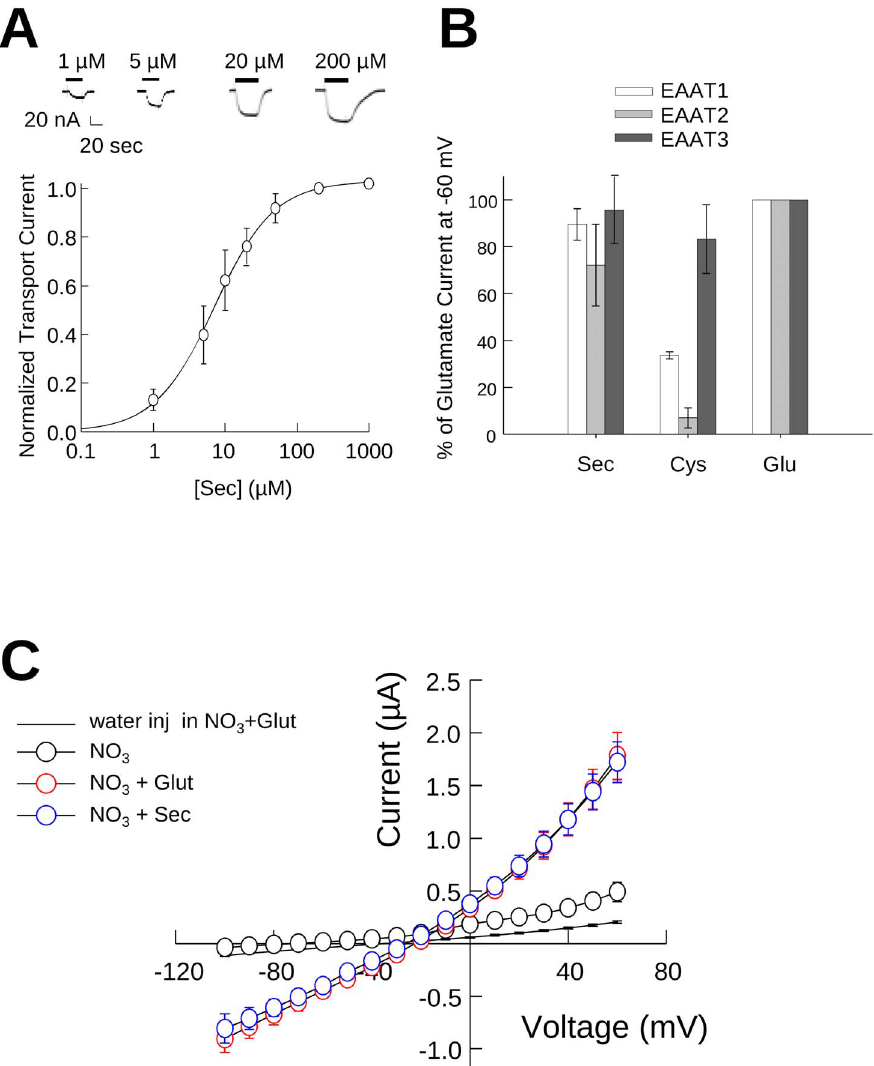
Figure 2. Selenocysteine is transported by EAATs 1–3. A) Representative recordings (upper panel) and averaged normalized transport currents (lower panel) measured at 2 60 mV as a function of the L-selenocysteine concentration in EAAT3 expressing oocytes (n=6). Data are presented as the mean and Std. dev. of the mean and fit with the Hill equation to estimate the Km for transport. B) Comparison of the maximal transport currents at 2 60 mV for L-selenocysteine and L-cysteine by EAAT1 (n . 3), EAAT2 (n . 5) or EAAT3 (n . 10) normalized to the maximal currents induced by L-glutamate measured in the same oocyte. C) Comparison of averaged current-voltage relationships recorded from oocytes expressing EAAT3 for both 1 mM glutamate (red symbols, n=4) and 1 mM selenocysteine (blue symbols, n=4). Black symbols indicate the averaged current voltage relationship of the same cells in the absence of substrate (n=4) and the solid line represents the average of water injected oocytes in the presence of 1 mM glutamate